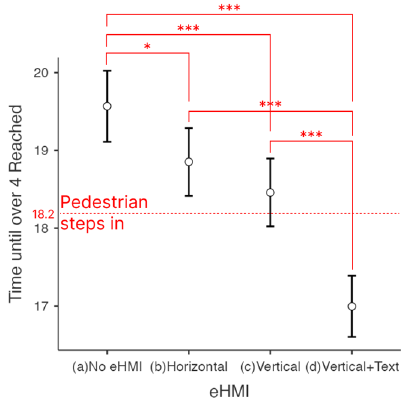
Figure 6. Response time (s): Time until over 4 reached. * p < 0.05, *** p < 0.001.